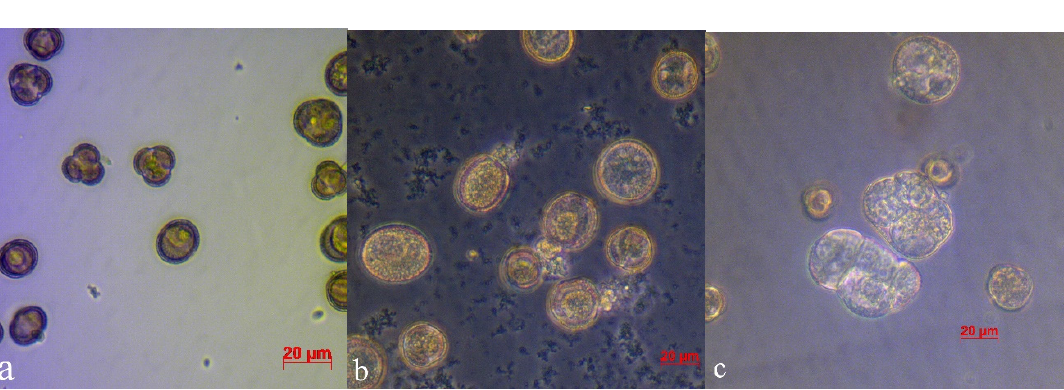
Figure 1. Culture of B. napus microspores: ( a ) in a medium without antibiotics after 1-day cultivation; ( b ) microspore development in medium without antibiotics after 5 days cultivation with traces of bacterial contamination; and ( c ) division of microspores in medium with ampicillin on day 5 day of cultivation.